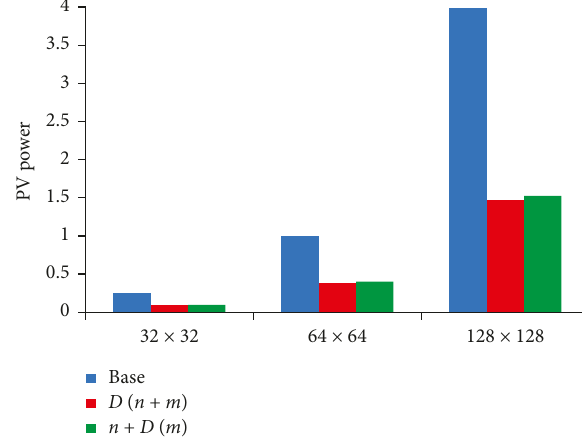
Figure 7: PV power with different distribution schemes.